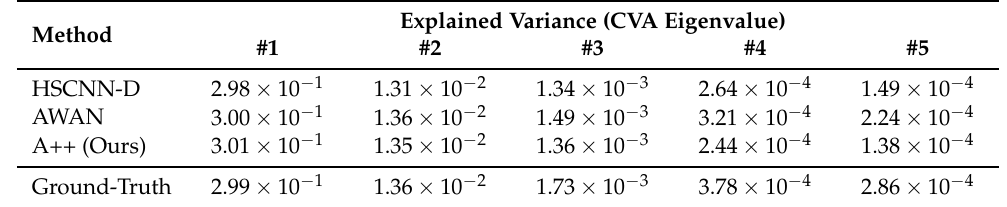
Table 5. The variance of the testing spectra recovered by HSCNN-D, AWAN and A++, and ground- truths explained by their respective top 5 (#1 to #5) CVA characteristic